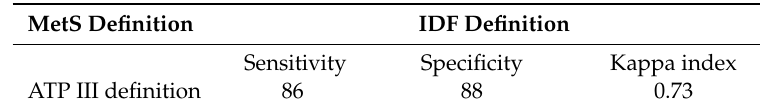
Table 3. Sensitivity, specificity, and kappa index of the IDF definition for detecting MetS under the